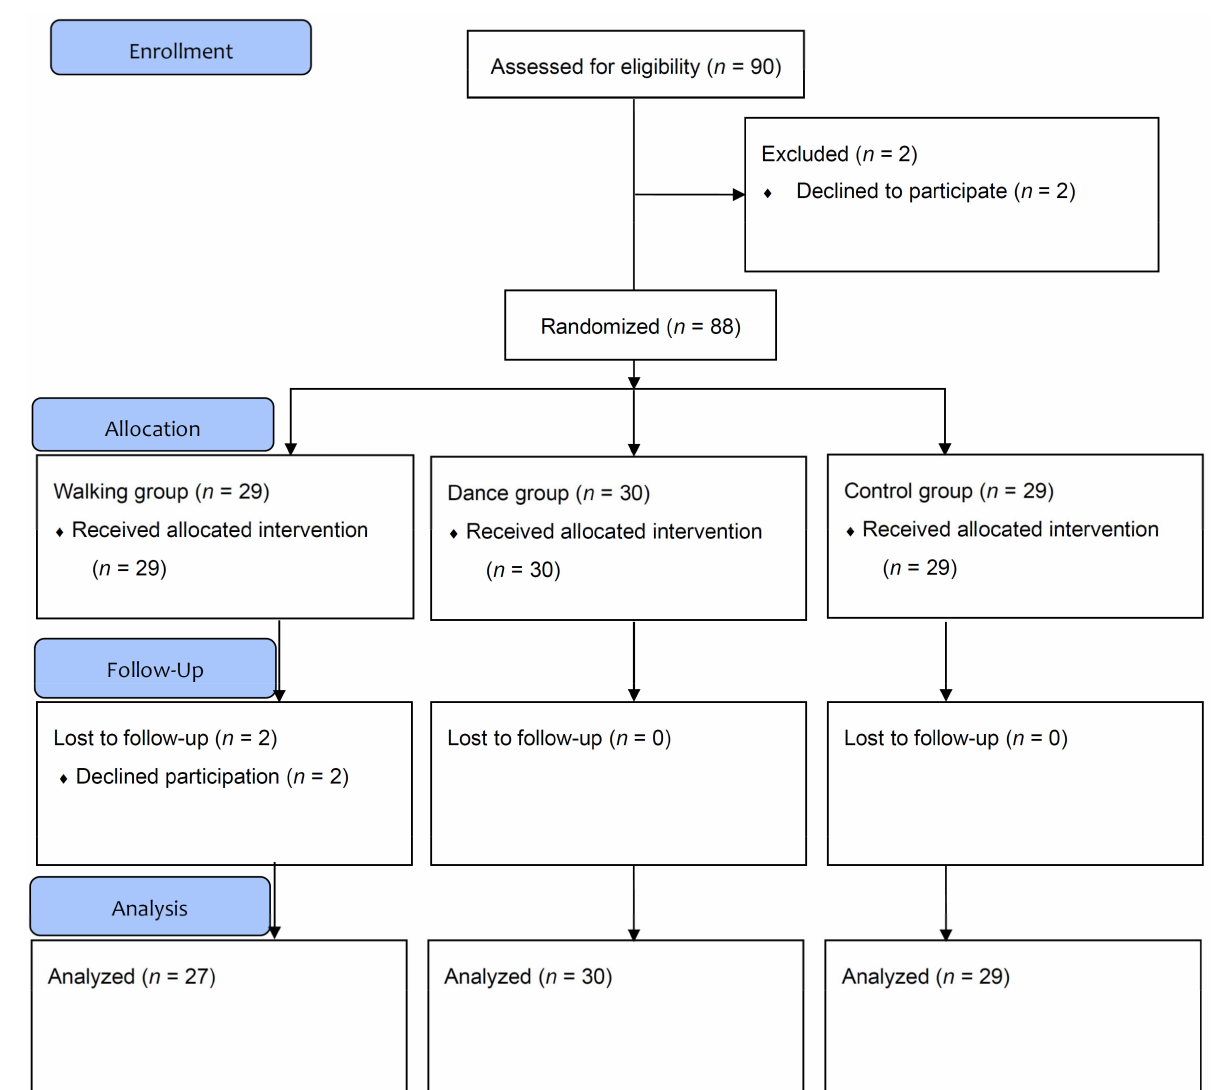
Figure 1. Consolidated Standards of Reporting Trials (CONSORT)